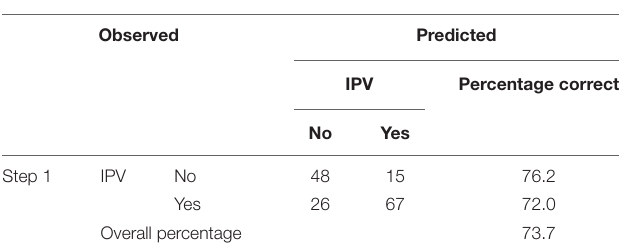
TABLE 11 | Classification Table (Block 3) a